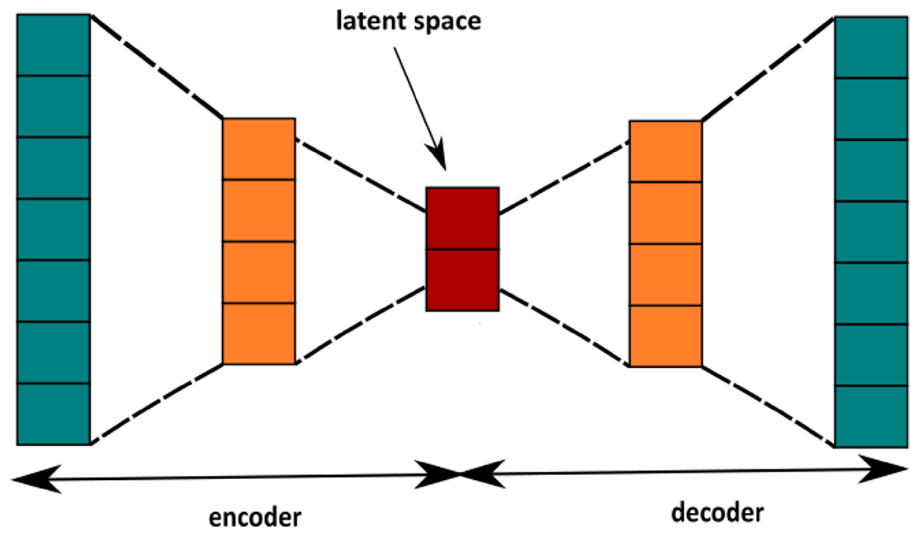
Figure 6. The scheme of autoencoder. The green squares stand for the input data, the orange ones indicate the intermediate layer of neurons. The red squares denote the latent space and provide the reduced representation of the